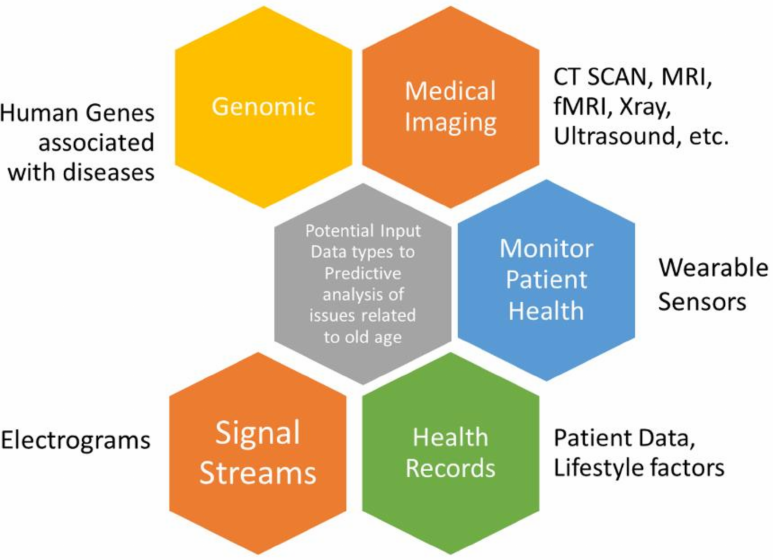
Figure 6. Potential data types in detecting aging-related